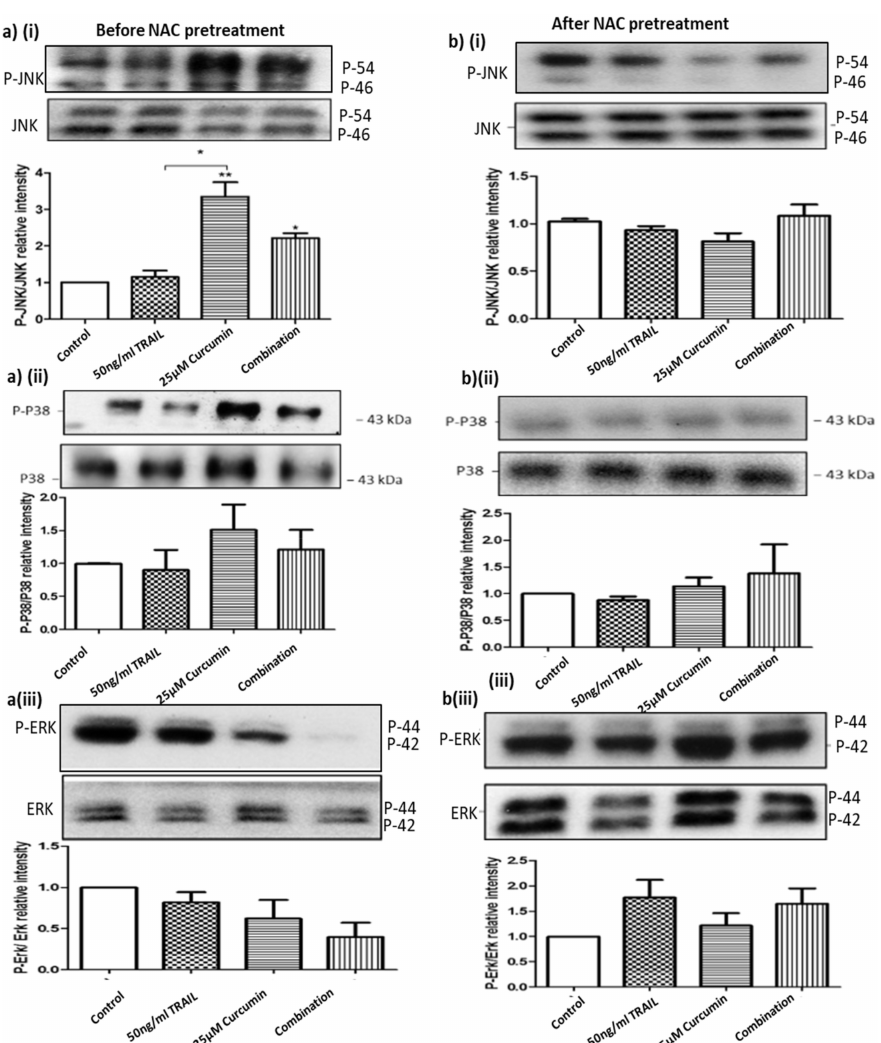
Figure 11. NAC pre-treatment abolished curcumin or curcumin / TRAIL combination-induced MAPK dysregulation ACHN cells were pre-treated with control medium (0.05% DMSO), 50 ng / mL TRAIL, 25 µ M curcumin or 50 ng / mL TRAIL / 25 µ M curcumin combination treatment for further 24 h. Whole cell lysates were prepared in RIPA bu ff er. Equal amounts of protein were separated by SDS-PAGE electrophoresis, transferred to nitrocellulose and indirectly probed for p-JNK, JNK p-P38, P38, and p-ERK and ERK using monoclonal antibodies and ECL detection system. To assess the e ff ect of pre-treatment with an antioxidant the ACHN cells were incubated with ( bi–iii ) or without ( ai–iii ) 10 mM NAC for 1 h prior to treatment of the cells as previously described. Whole cells lysates were assessed by Western blot indirectly probing for the aforementioned primary antibodies. One-way ANOVA was used to analyse the